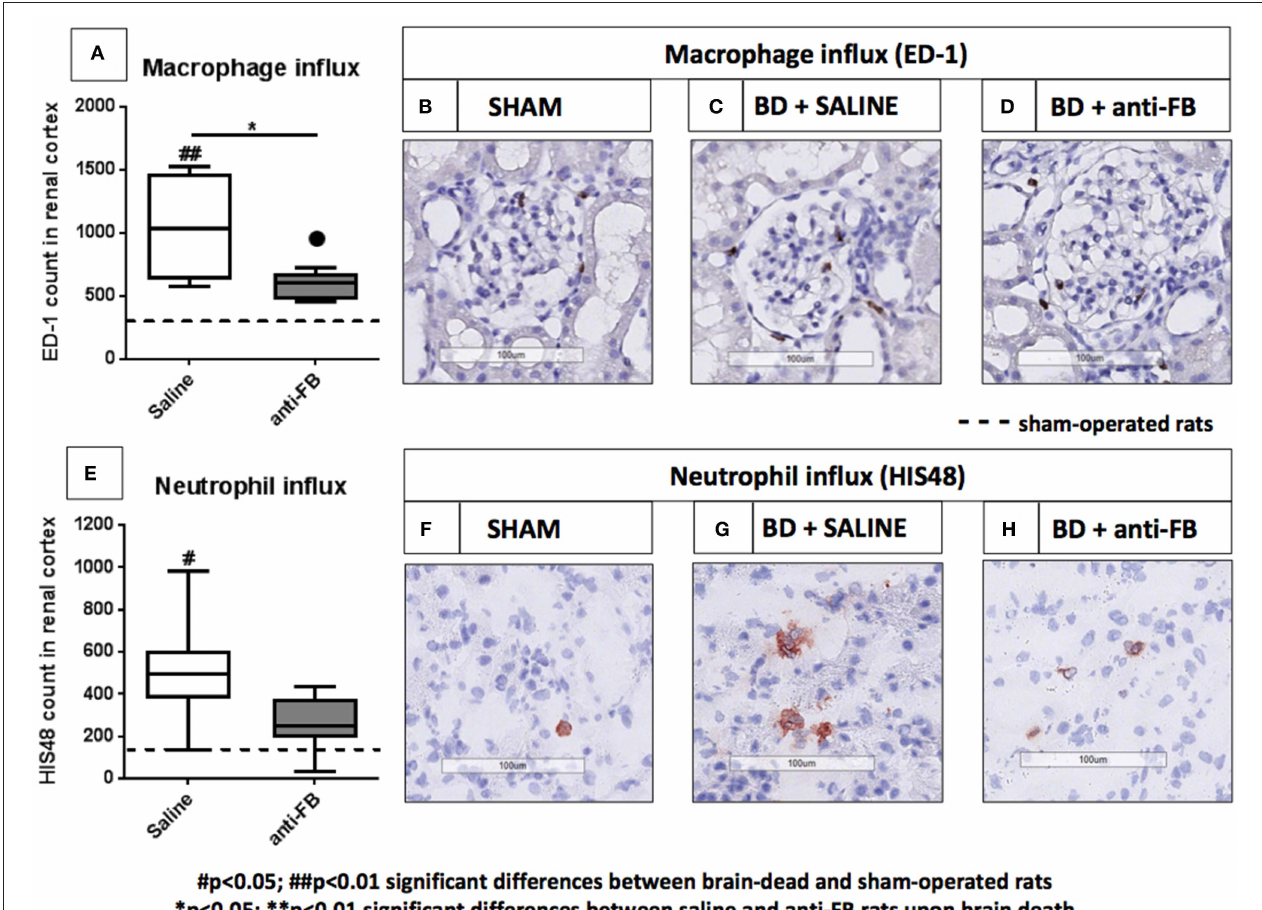
FIGURE 5 | Infiltrated leukocytes in the kidney after brain death in saline or anti-factor B treated rats. Infiltrated leukocytes in kidneys of sham-operated and brain-dead rats treated with saline or anti-factor B. (A) Renal neutrophil influx was scored in frozen sections from (B) sham-operated rats, (C) brain-dead rats treated with saline, or (D) brain-dead rats treated with anti-factor B. (E) Renal macrophage influx was scored in paraffin-embedded sections from (F) sham-operated rats, (G) brain-dead rats treated with saline, or (H) anti-factor B. Sections were quantified for the number of positive cells in the renal cortex using Aperio Imagescope (objective 50x − 200x) and ImageJ Software. All pictures are presented at 200x magnification. Data are shown as median ± IQR. Data were analyzed by Mann Whitney- U -test and Bonferroni post-hoc test, asterisks above the bars denote significant differences between the brain-dead rats (* p < 0.05, ** p < 0.01, and *** p < 0.001). The dashed line represents the sham-operated rats. # Significant differences between the brain-dead rats vs. sham-operated rats ( # p < 0.05, ## p < 0.01, and ### p < 0.001). Anti-FB, anti-factor B.